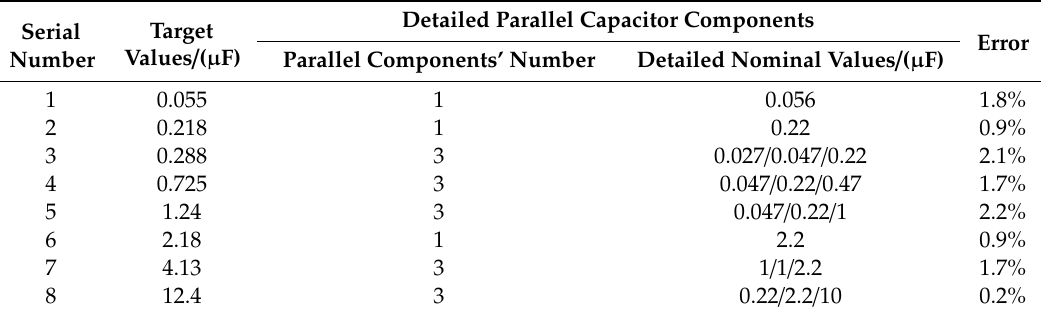
Table 6. Detailed parallel capacitor components to form the required